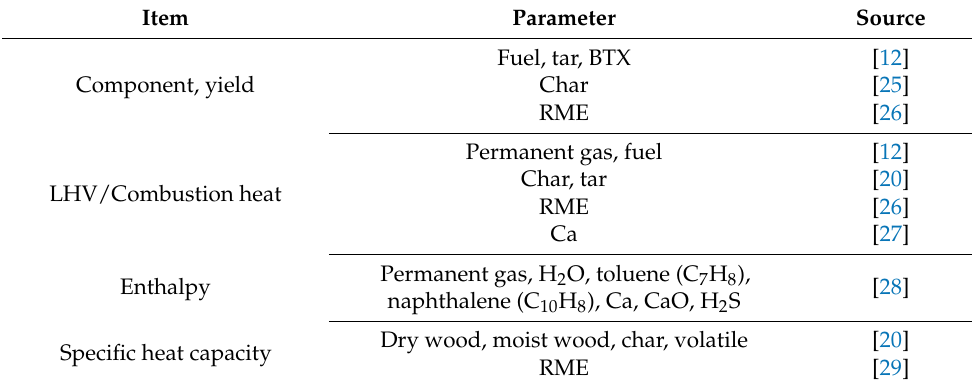
Table 2. Sources of physical and chemical properties of related substances.